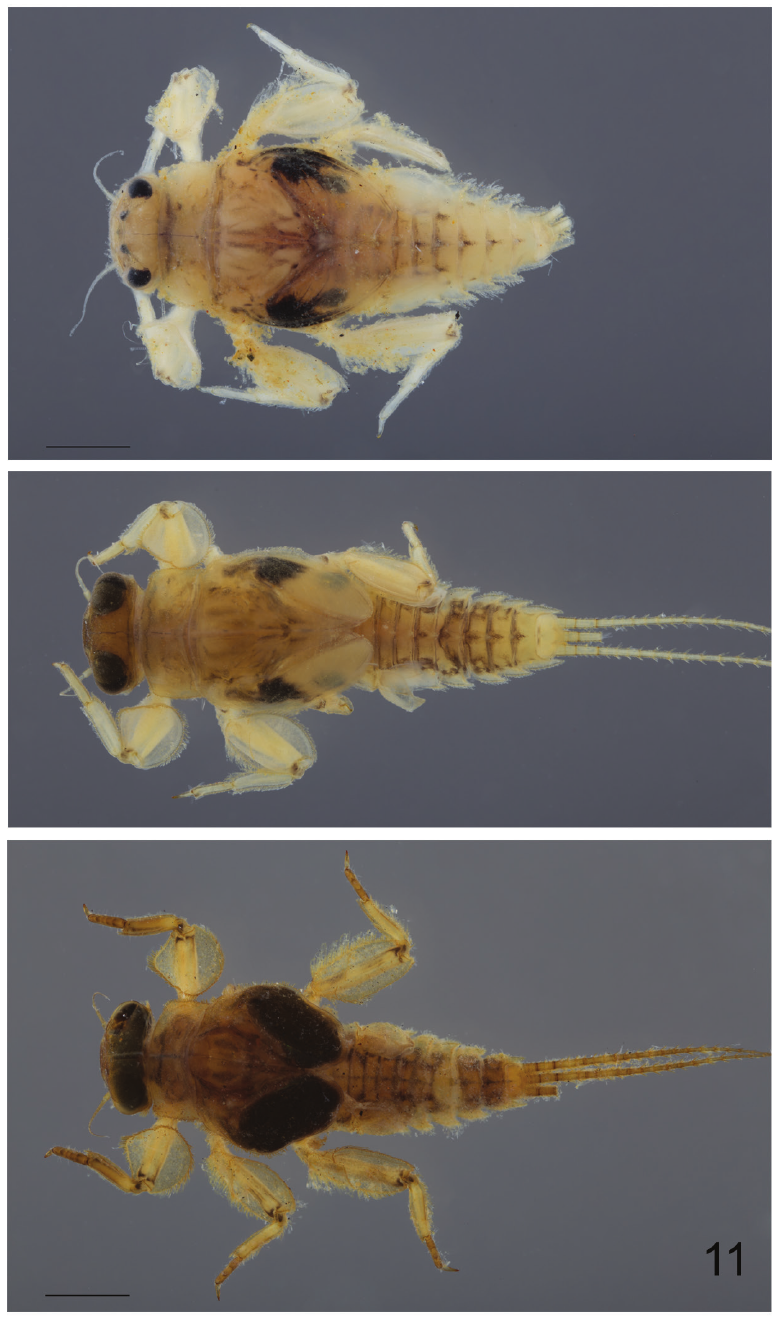
Figure 11. Manohyphella keiseri Allen, 1973 from top to bottom: medium size female larva from Ranomafana area (P0643), medium size male larva from Marojejy area (P1020), full grown male larva from Andasibe area (P2183). Scale bar: 1